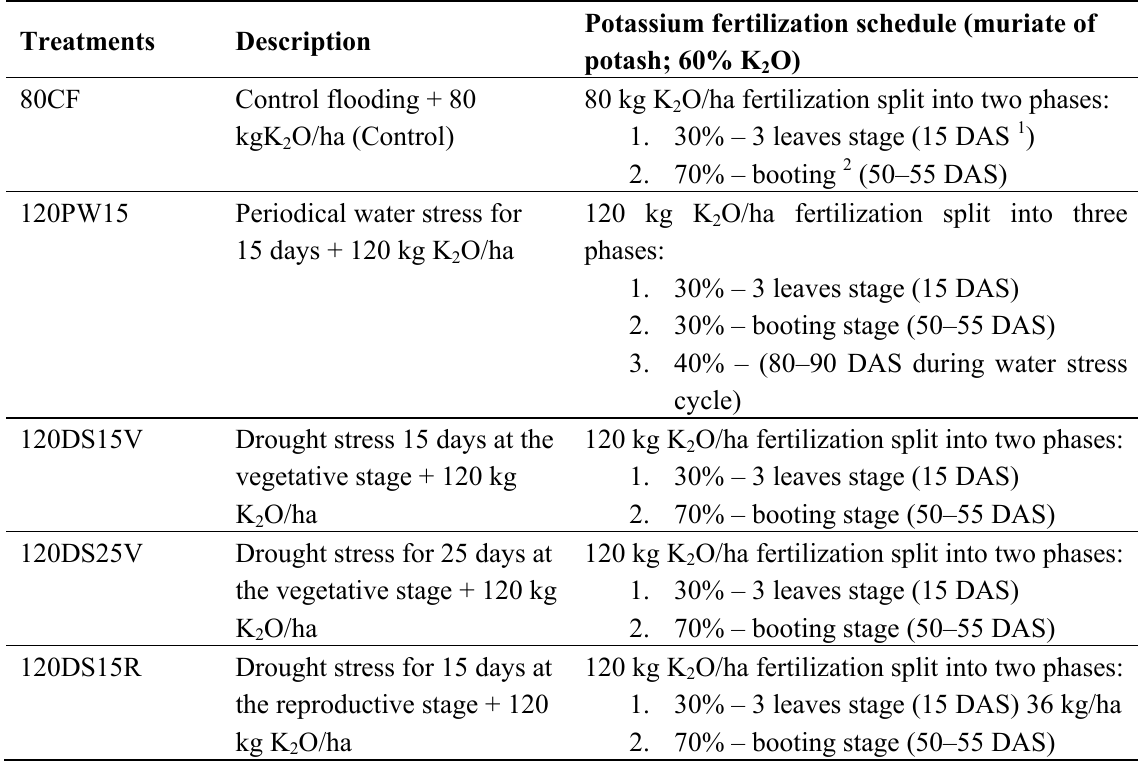
Table 9. Potassium fertilization schedule during the